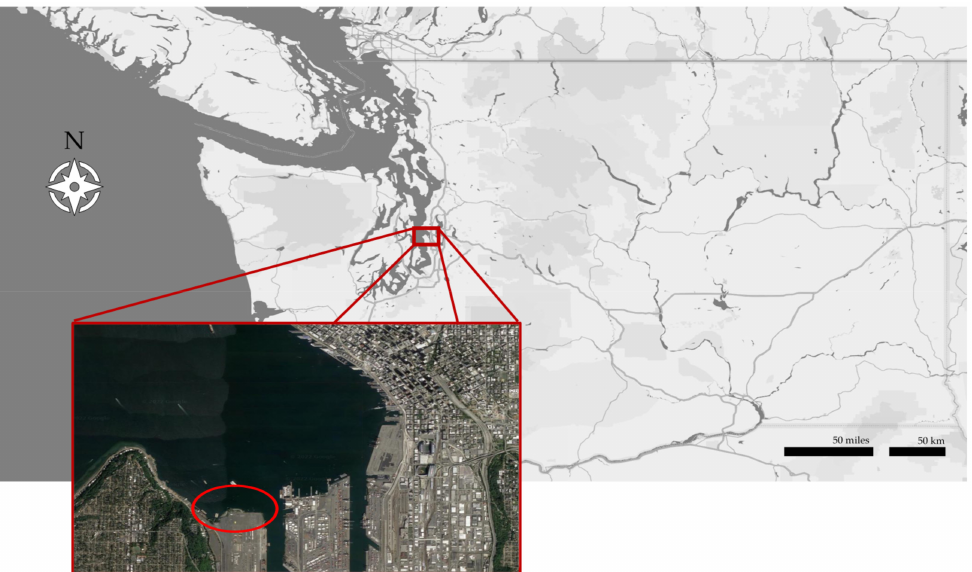
Figure 1. Location of Puget Sound Resources in West Seattle, Washington. The ellipse shows the location of the site. Imagery ©2022 CNES/Airbus, Landsat/Copernicus, Maxar Technologies, U.S. Geological Survey, USDA Farm Service Agency, Map data